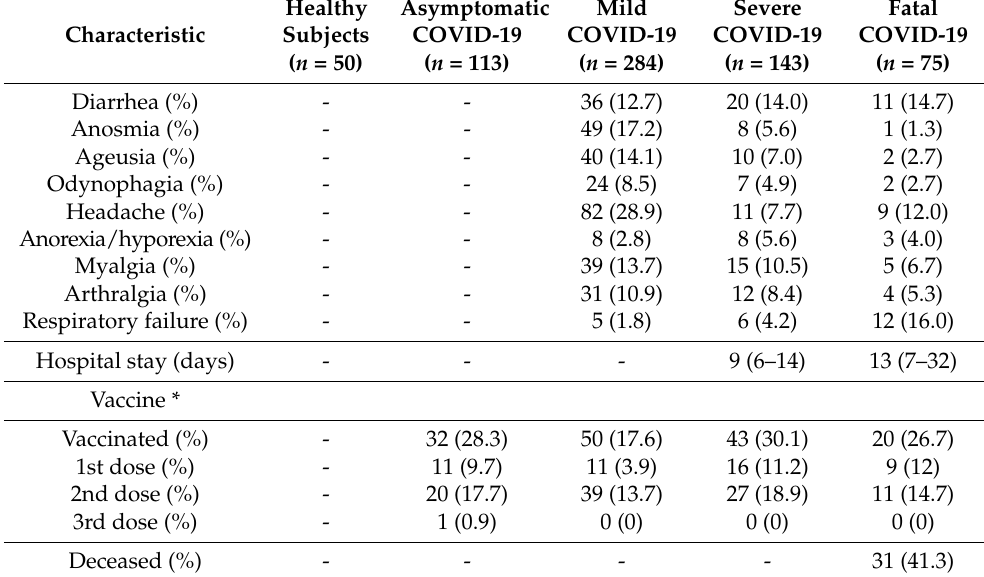
Healthy Subjects